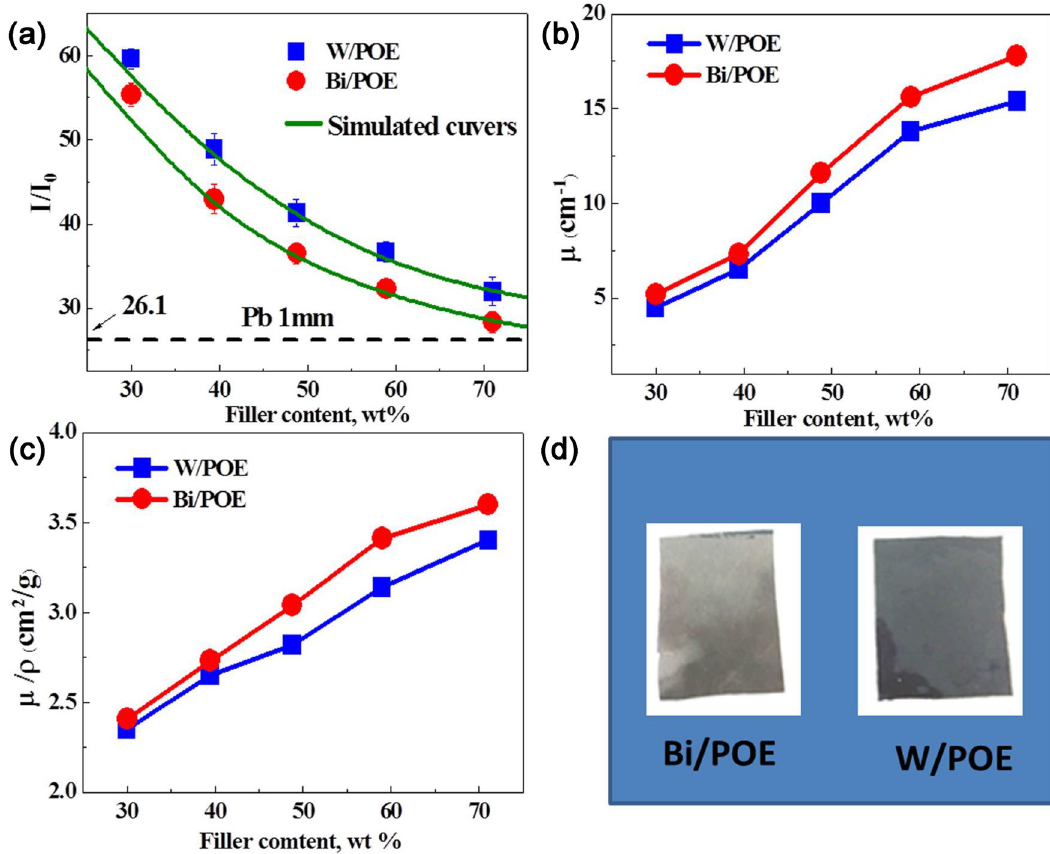
Figure 1. ( a ) Dose ratio (I/I 0 ) of X-ray passed through the two composites (W/POE and Bi/POE). Correspondingly, the simulation curves were also displayed; ( b ) Linear attenuation coefficient versus the amount of metal content; ( c ) Mass attenuation coefficient versus the amount of metal content; ( d ) Digital images of the W/POE and Bi/POE